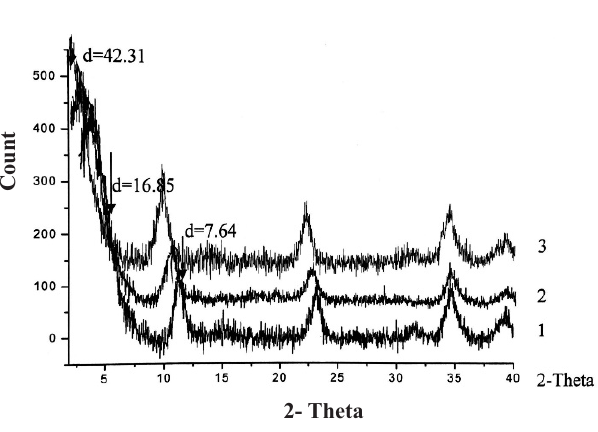
Figure 2.a : Powder XRD patterns of (1) Mg/ Al NO 3- LDH (2) Mg/ Al SDS LDH (3) Trypsin entrapped within Mg/ Al SDS LDH